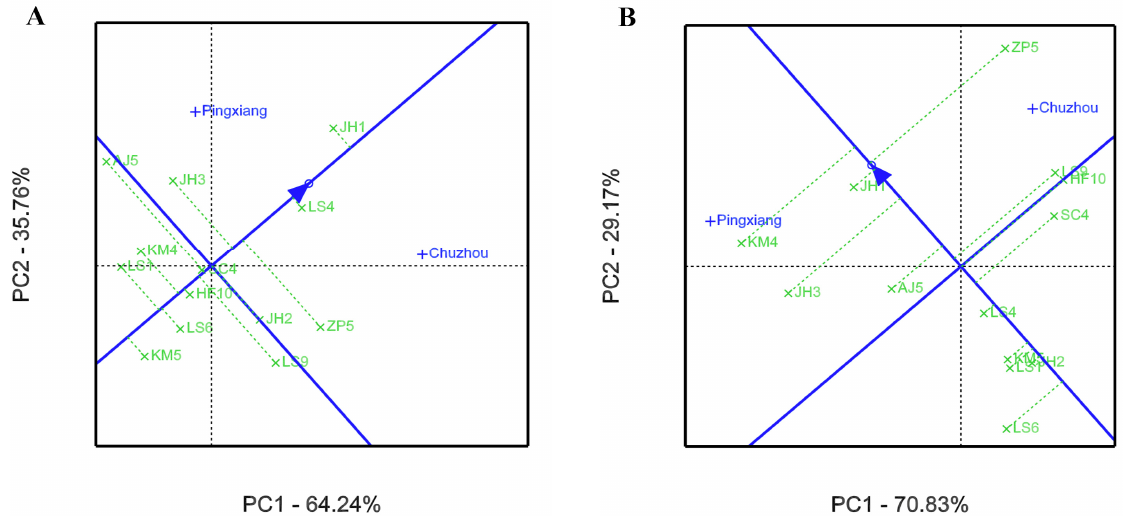
Figure 6. Average environment coordination (AEC) views of the GGE biplot based on environment-focused scaling in the leaves of C. paliurus genotypes evaluated for total flavonoid content ( A ) and total triterpenoid content ( B ).